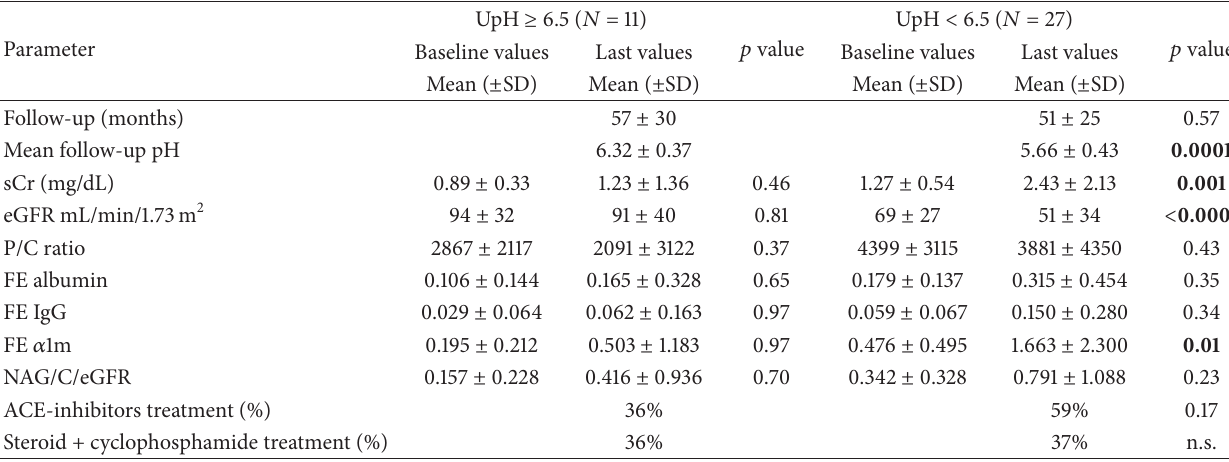
Table 2: Comparison of functional and proteinuric parameters at baseline and at the last observation in a subset of 38 IMN patients (high UpH group 𝑁 11, low UpH group 𝑁 27) with 5 serial measurements along 56 ± 26 months (range